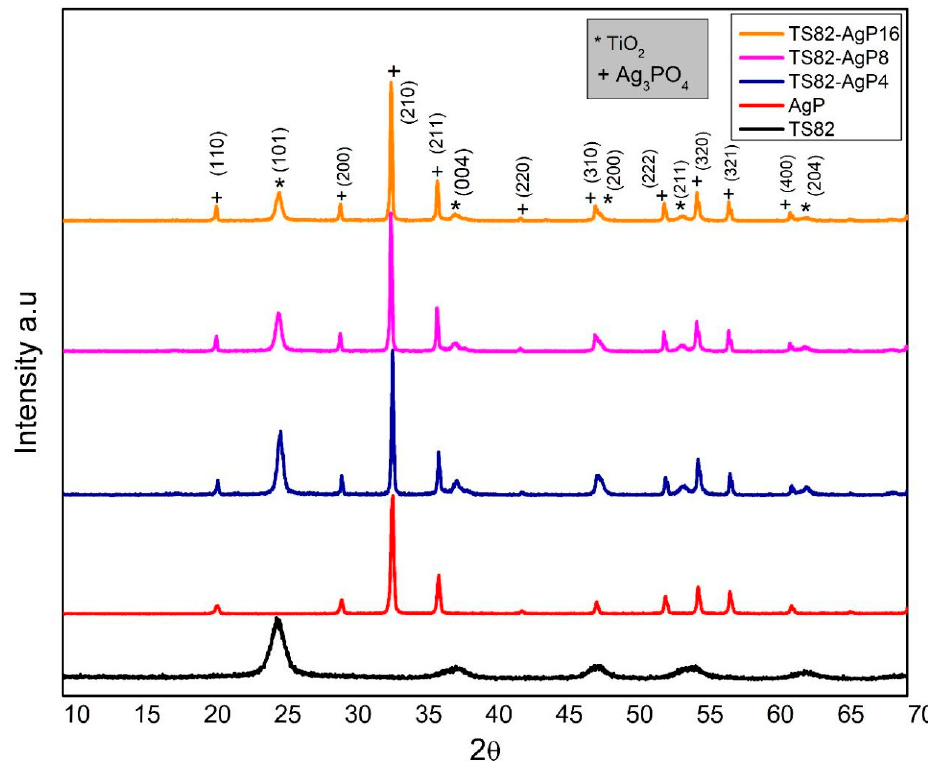
Figure 1. XRD patterns of TS82, pure Ag 3 PO 4 (AgP), and composites with different TS82/AgP ratios. The morphology of Ag 3 PO 4 and TS82 microspheres is presented with the SEM micro- graph (Figure 2a,b, respectively). The Ag 3 PO 4 particles have an irregular and polyhedral morphology and exist in an aggregated state. From Figure 2b, it is clear that TS82 mi- croparticles possess spherical morphology and smooth surfaces. Some spheres are in a broken state, unveiling the hollow nature of the microspheres. The size of the TS82 could be estimated in the range of submicron to 5 µ m. The SEM micrograph of the composite catalyst TS82/AgP16 in Figure 2c shows that the Ag 3 PO 4 nanoparticles are uniformly distributed on the surface of TS82 microspheres and titania silica microspheres are decorated with Ag 3 PO 4 nanoparticles with an average size of 40 nm (inset of Figure 2d). It is also noteworthy to observe that in case of pristine Ag 3 PO 4 , aggregated particles of 200 to 300 nm were formed due to rapid nucleation in the reaction solution leading to crystal growth [43]. However, this feature is absent in the composite material indicating that the TS82 microspheres act as nucleation controlling medium leading to nearly uniform distribution of the small sized